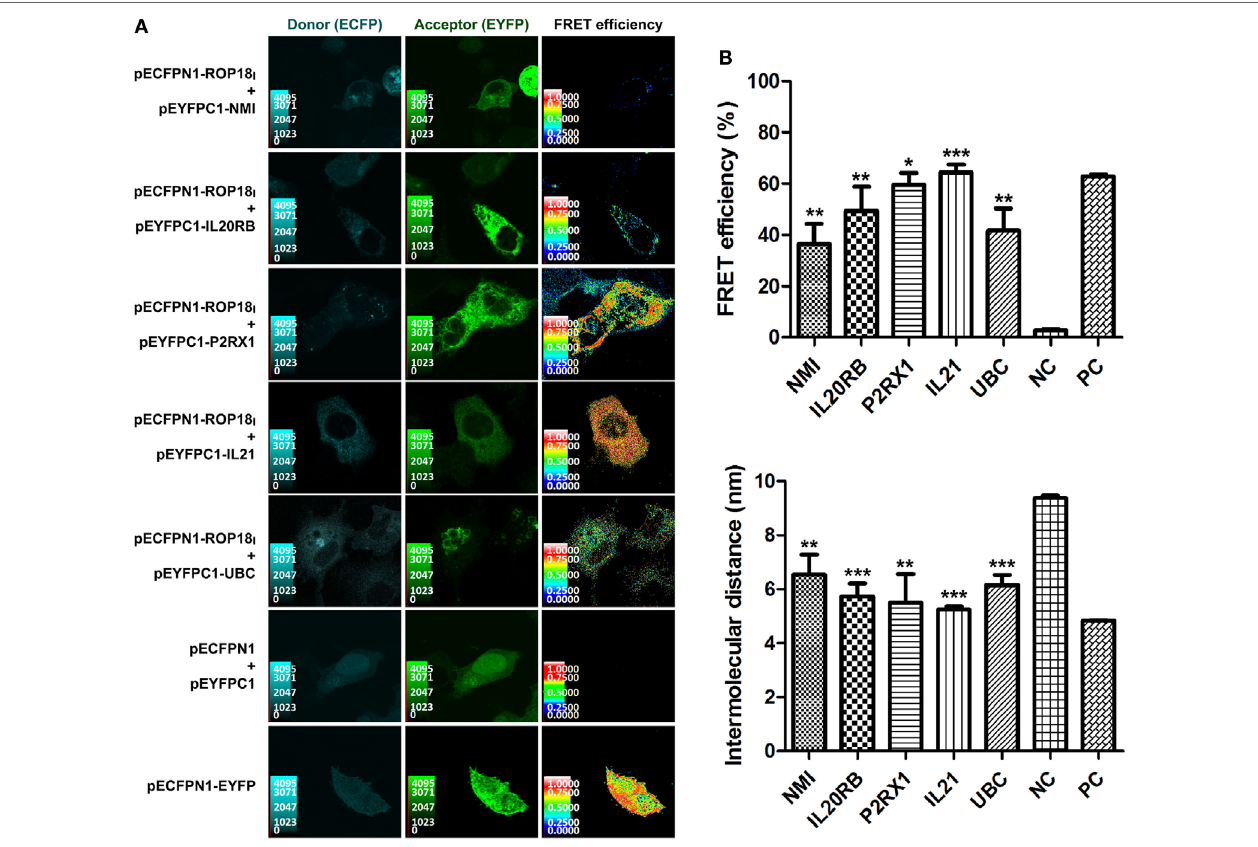
FigUre 2 | Validation of the Tg ROP18-interacting proteins by SE-FRET assay. (a) Co-localization and FRET interaction of ROP18 I with NMI, IL20RB, P2RX1, IL21, and UBC. Localization and co-localization of ROP18 I and the five indicated candidates are shown in the donor channel (column 1) and the acceptor channel (column 2), respectively. The FRET efficiency is shown in column 3, in which a thermal pseudo color-matched FRET signal intensity scale is indicated for each image. (B) Quantitative analysis of FRET efficiency and intermolecular distance between ROP18 I and the five indicated candidates. Error bars represent the means ± SD of triplicates. Student’s t -tests results are between the six experimental groups and NC, * p < 0.05; ** p < 0.01; *** p < 0.001. Abbreviations: NC, negative control; PC, positive